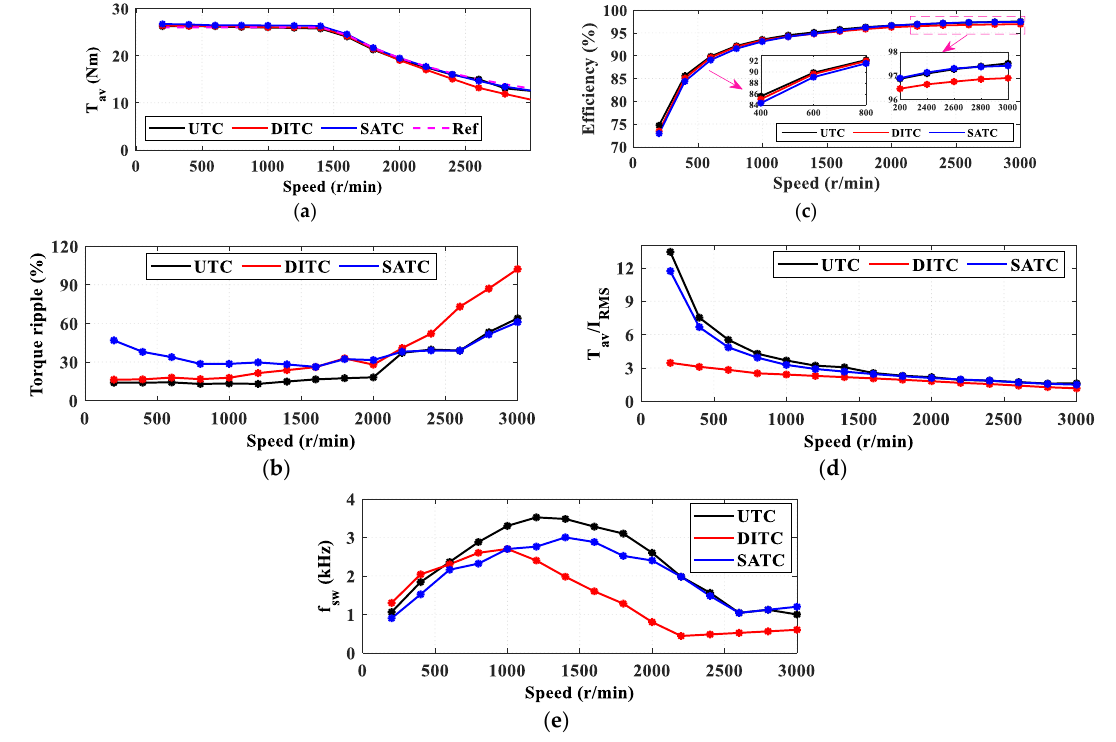
Figure 19. The steady state characteristics under full load conditions. ( a ) Average torque; ( b ) torque ripple; ( c ) efficiency; ( d ) torque/current ratio; ( e ) switching frequency.